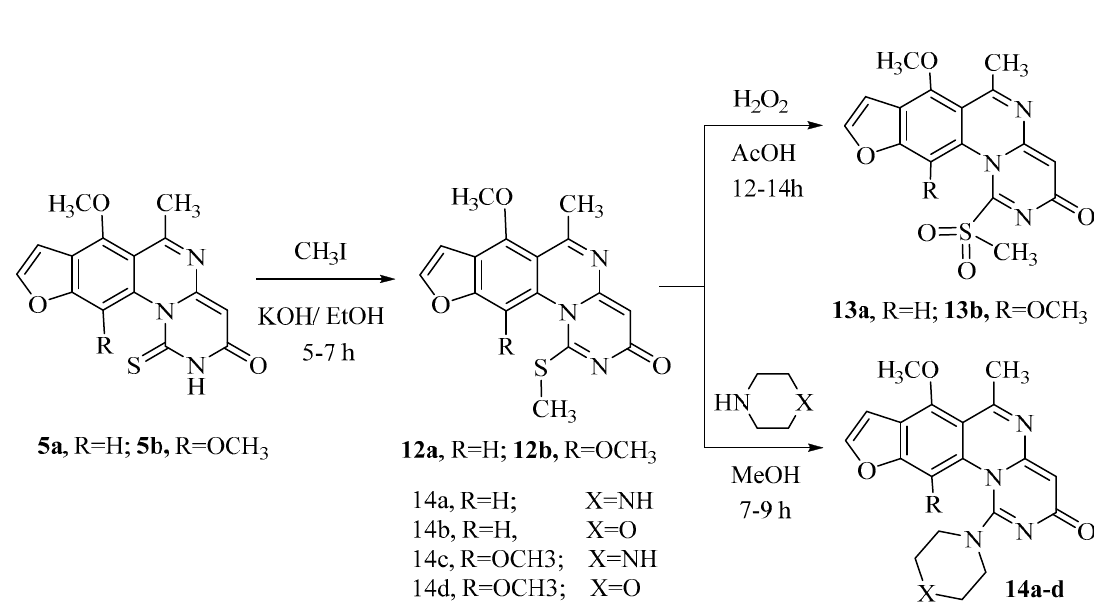
Scheme 4. Synthesis of piperazine, morpholine, -furopyrimido-quinazolinone derivatives.